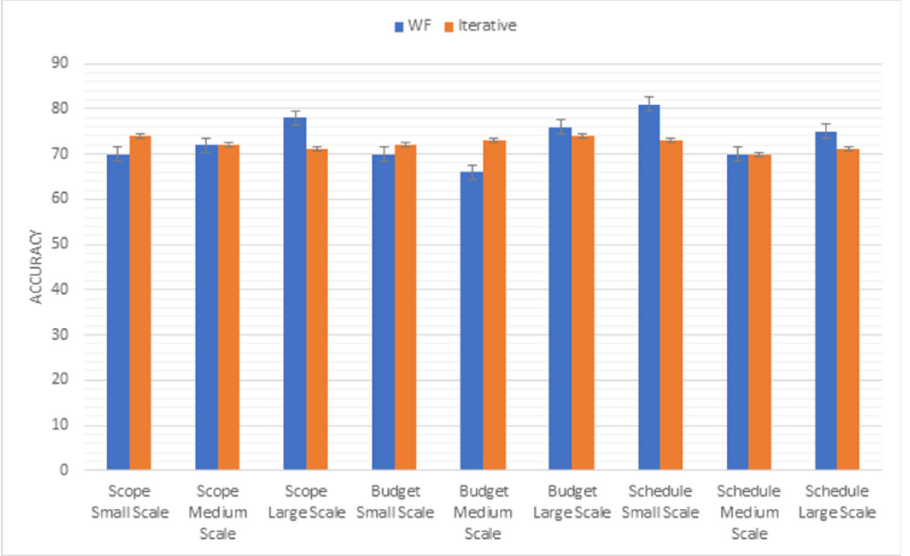
Fig 7. Graphical representation of waterfall vs iterative (first triangle)